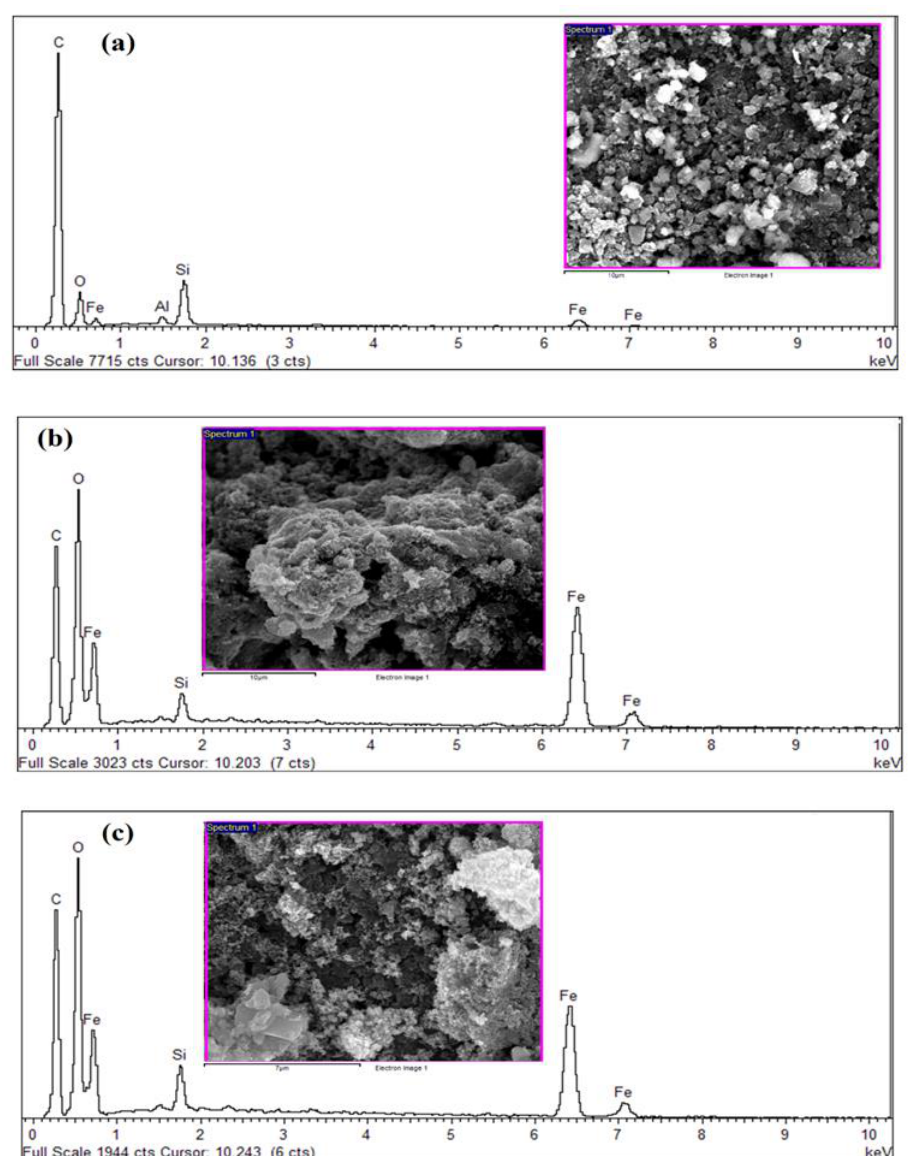
Figure 2. EDX spectra of the as-synthesized NBC ( a ), and MBC prior to adsorption ( b ), and after adsorption ( c ).